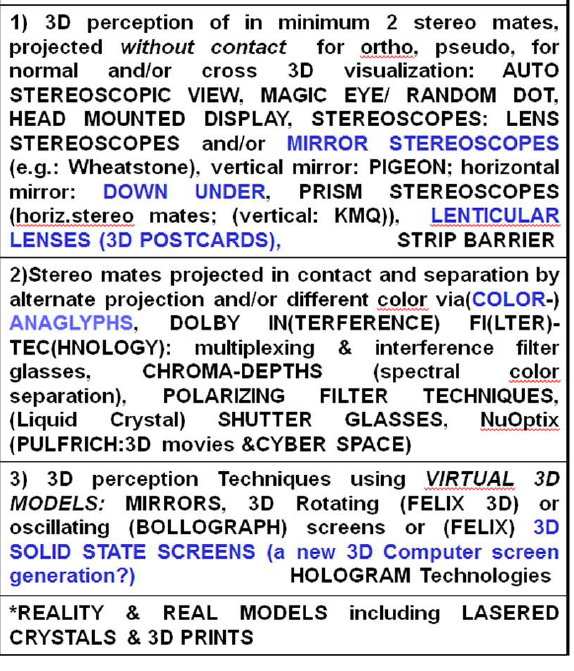
Figure 9. In addition to the access to international archives the